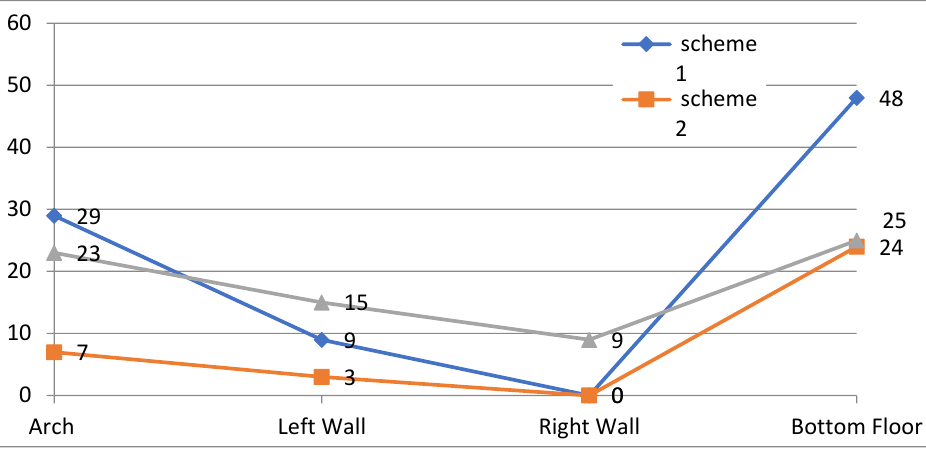
Figure 9. Crack depth (m) of SR after excavation of main transformer chamber.